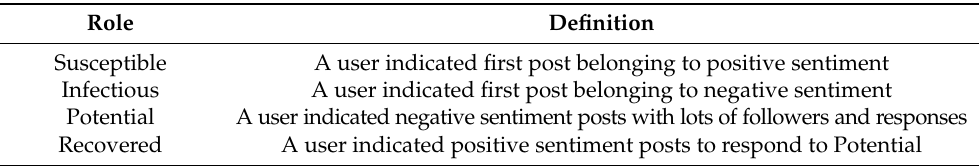
Table 7. Definitions of